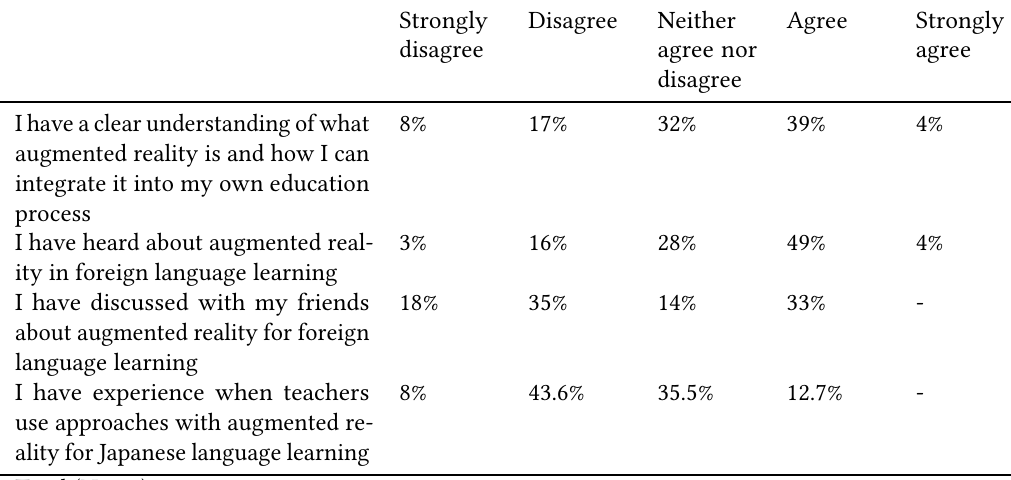
The results of students’ survey on their understanding of augmented reality in Japanese language learning process